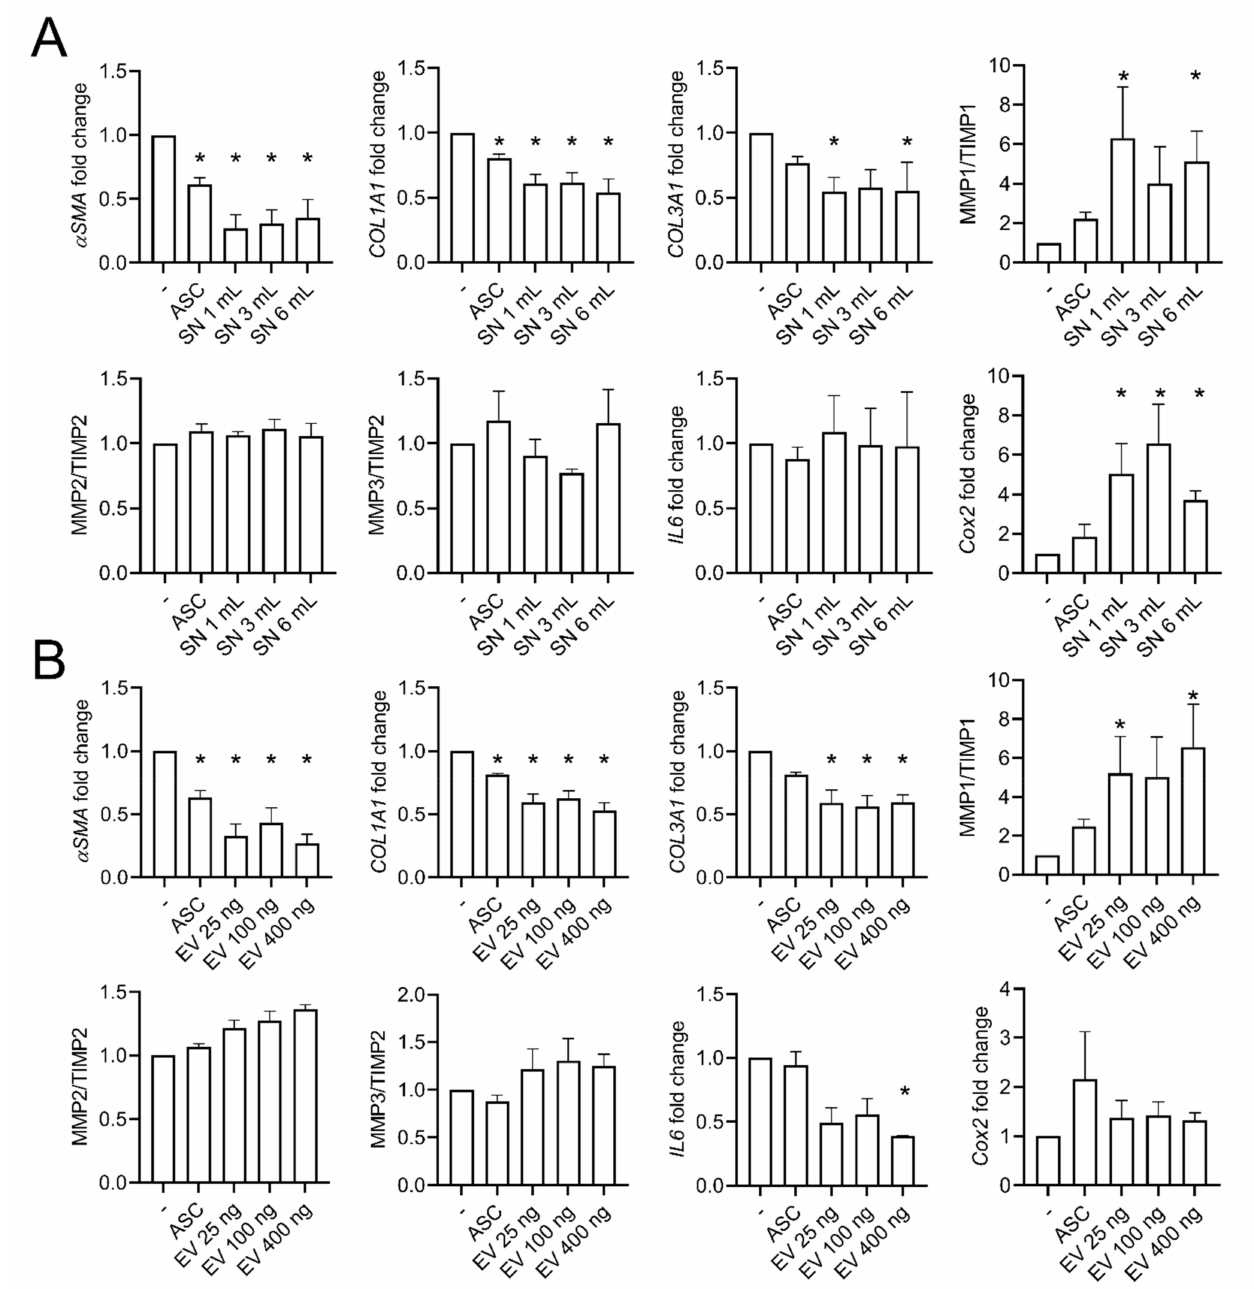
Figure 5. Effects of ASC-EVs on TGF β 1-stimulated fibroblasts. ( A ) Fold change of gene expression in TGF β 1-stimulated fibroblasts using different volumes of conditioned supernatants (SN) from healthy ASCs ( n = 4). ( B ) Fold change of gene expression as in ( A ) ( n = 18). *: p <